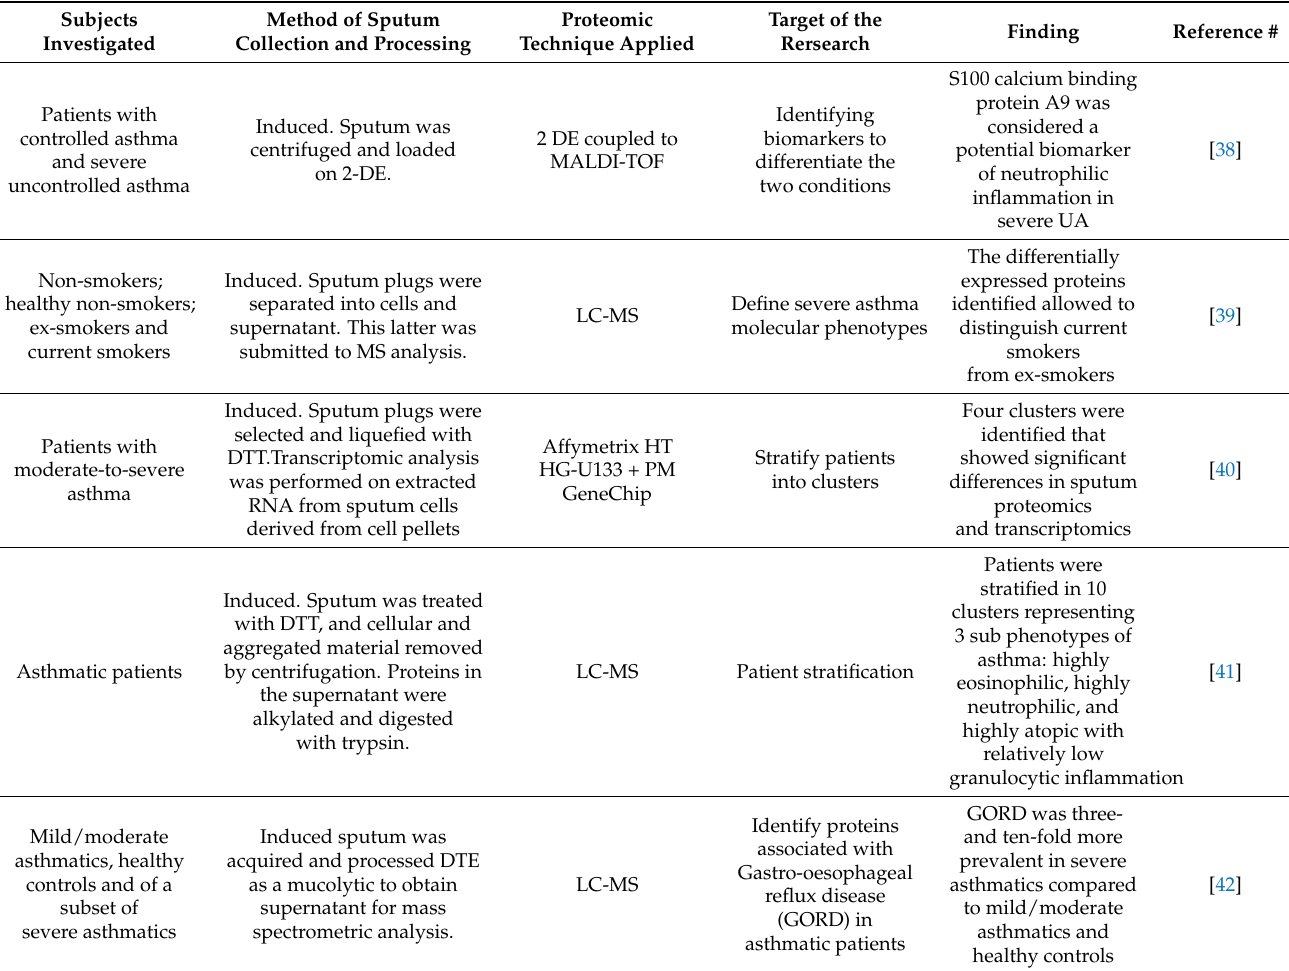
Table 3. List of articles dealing with proteomics of sputum in patients with asthma.